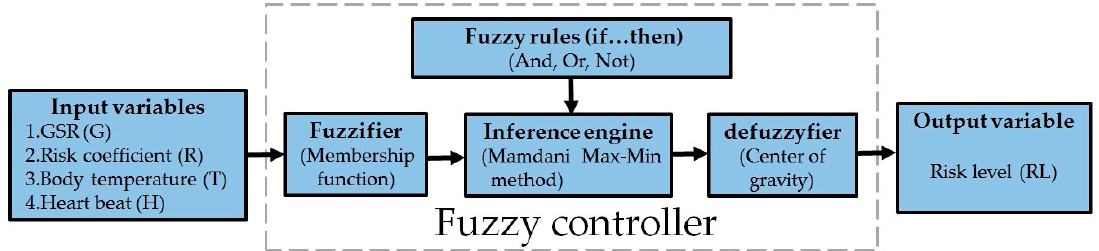
Figure 7. Fuzzy controller implementation process. Table 3. Inputs and output value definition.